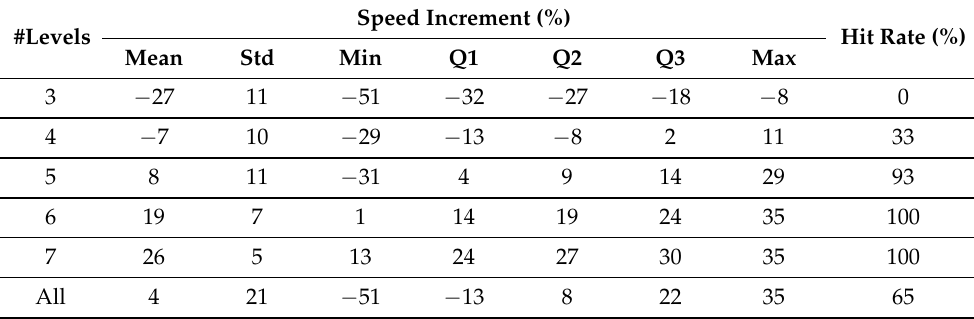
Table 6. Speed increment of CARRY-MAP with respect to VIV-MAP in area optimization.